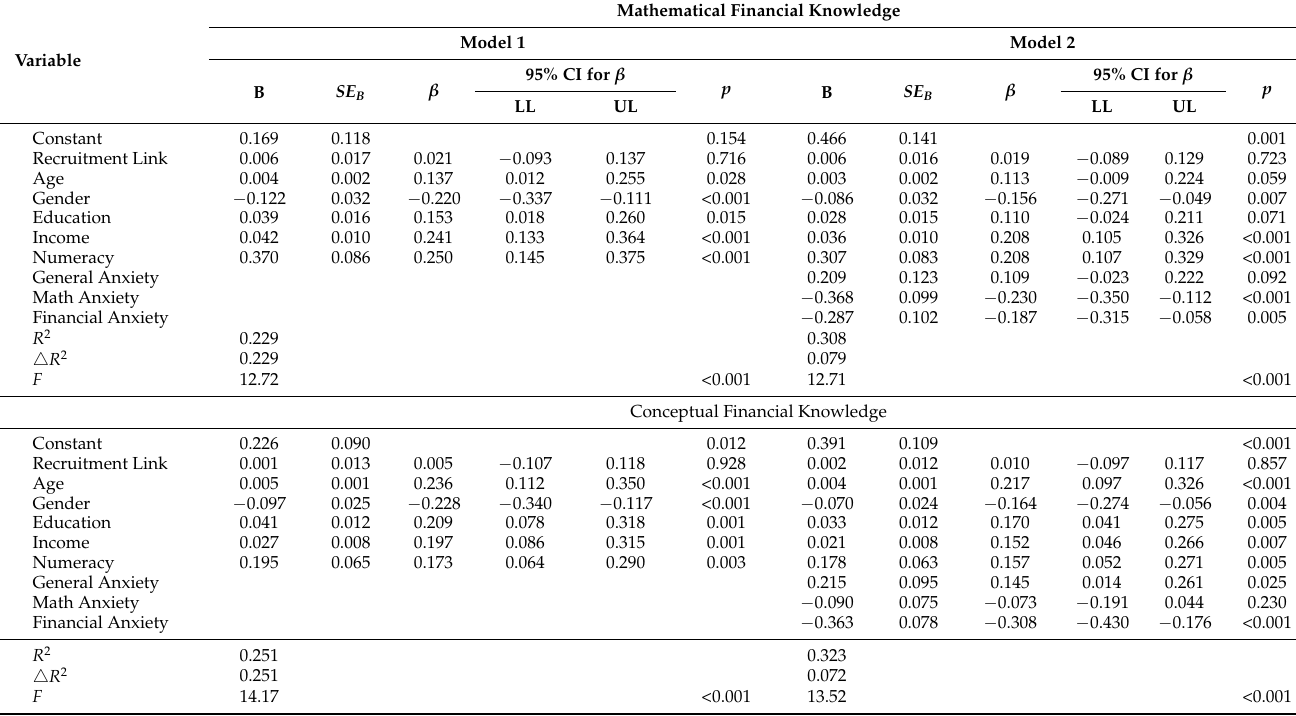
Table 2. Multiple Regression Assessing Factors Related to Mathematical and Conceptual Finan- cial